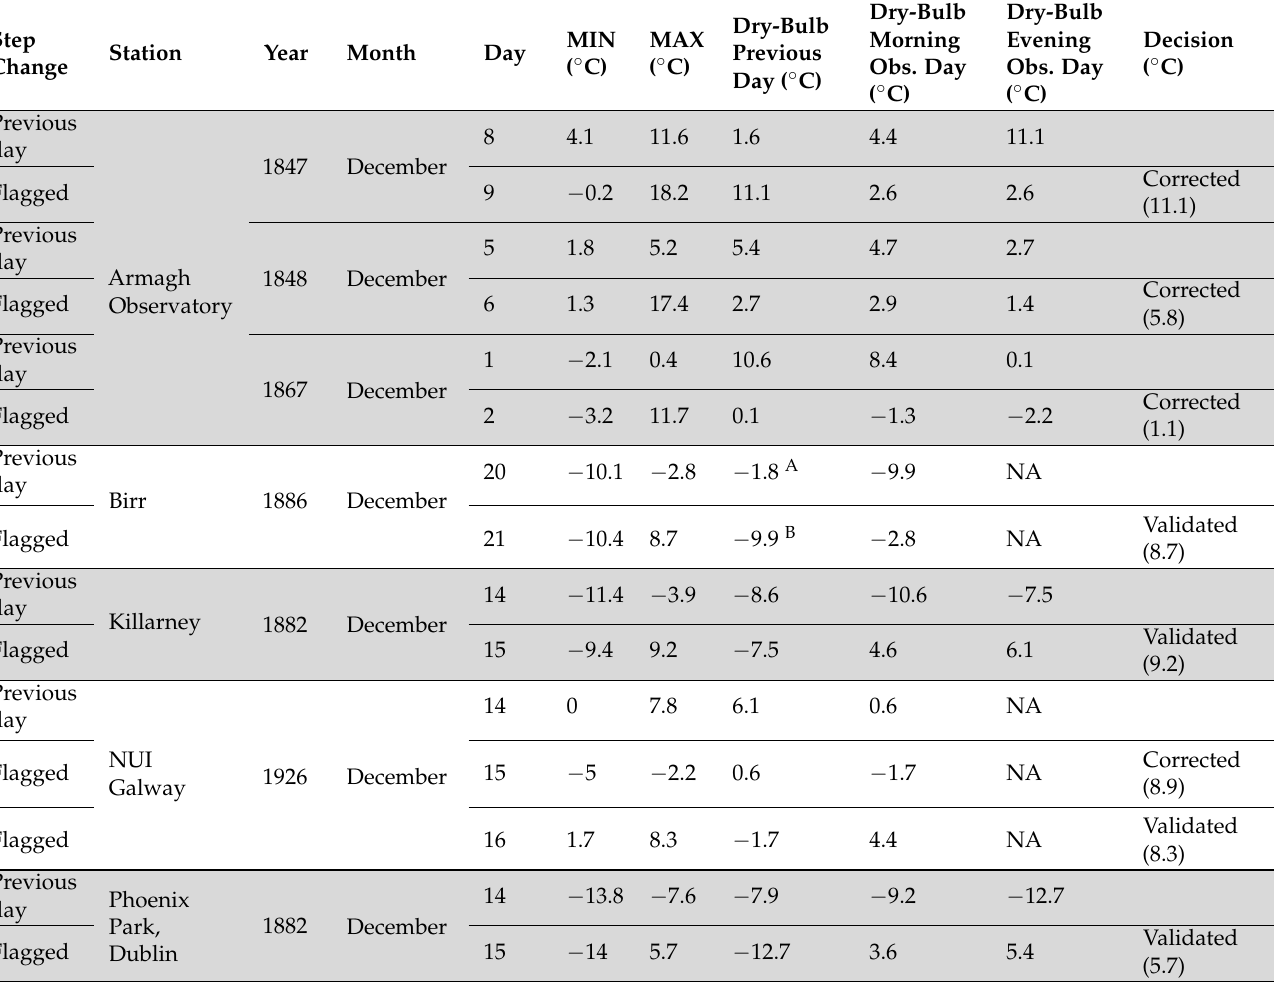
Table A7. Flagged step-change in daily MAX higher than 4.5 standard deviation of the mean (flag 7) and the dry-bulb thermometer registered on previous and observation